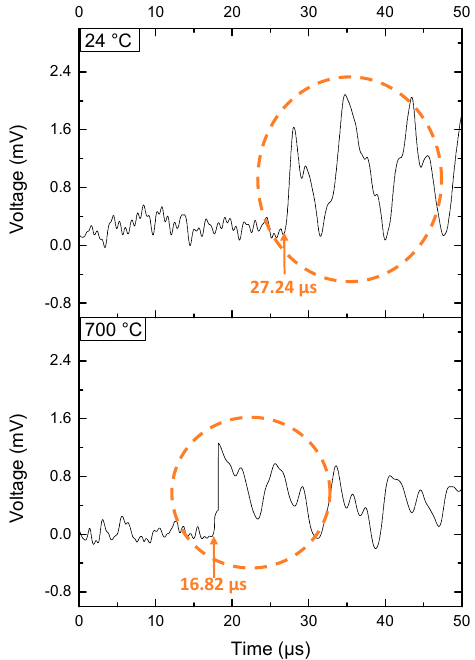
Figure 10. Ultrasonic signals for 700 °C high temperature test.